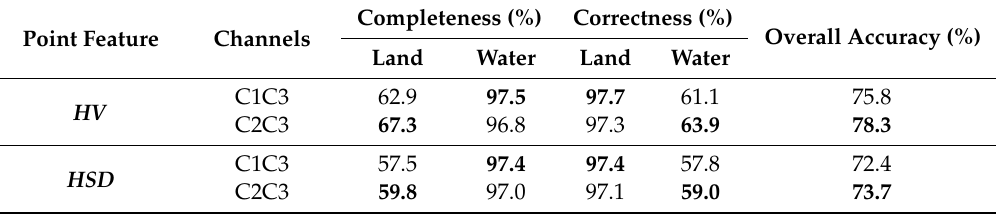
Table 5. Threshold values I thresh and ICOV thresh for the three channels.